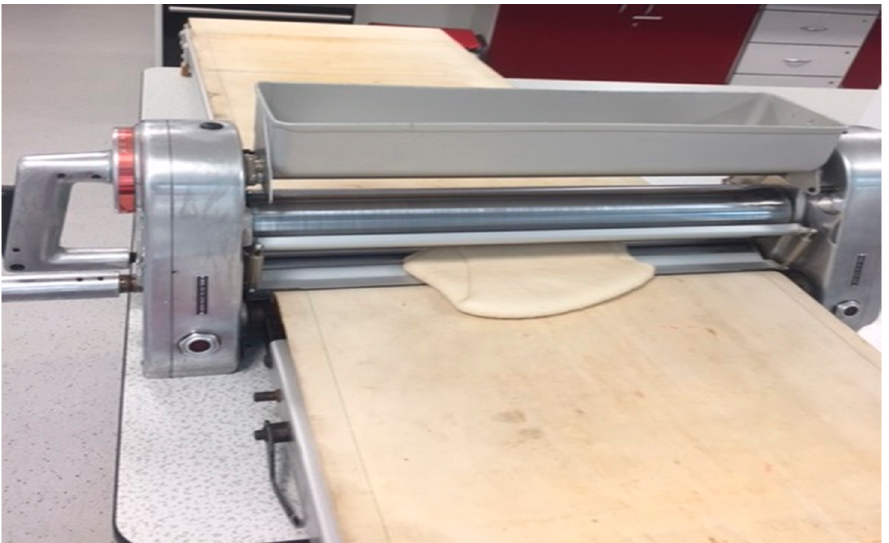
Figure 1. Rondo dough sheeter.